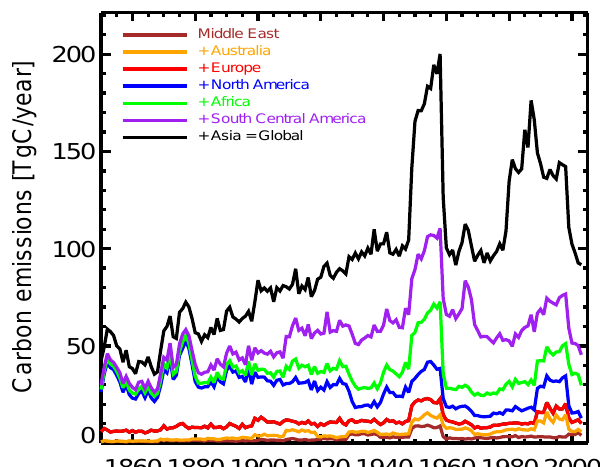
Fig. 9. Annual mean fire emissions from deforestation [TgC/year] as simulated in simulation AB-FULL. The contribution of each region is stacked onto the region plotted below, so that the black line represents the global sum of fire emissions from